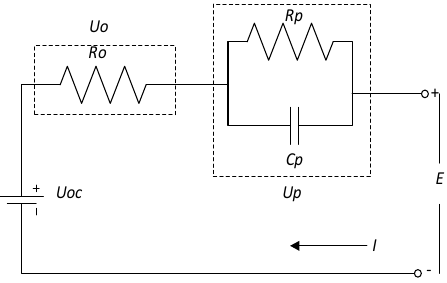
Figure 2. The equivalent circuit model (ECM) for lithium-ion battery.